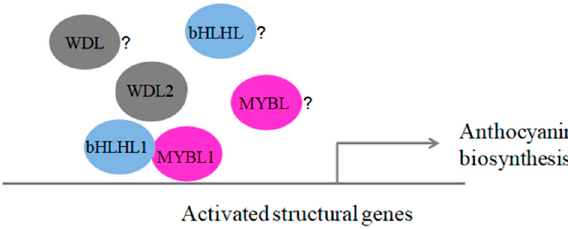
Figure 5. A proposed model for how VcMYBL1, VcbHLHL1, and VcWDL2 expression can promote Figure 5: A proposed model for how VcMYBL1, VcbHLHL1, and VcWDL2 expression can promote anthocyanin biosynthesis in blueberry fruits. anthocyanin biosynthesis in blueberry fruits.